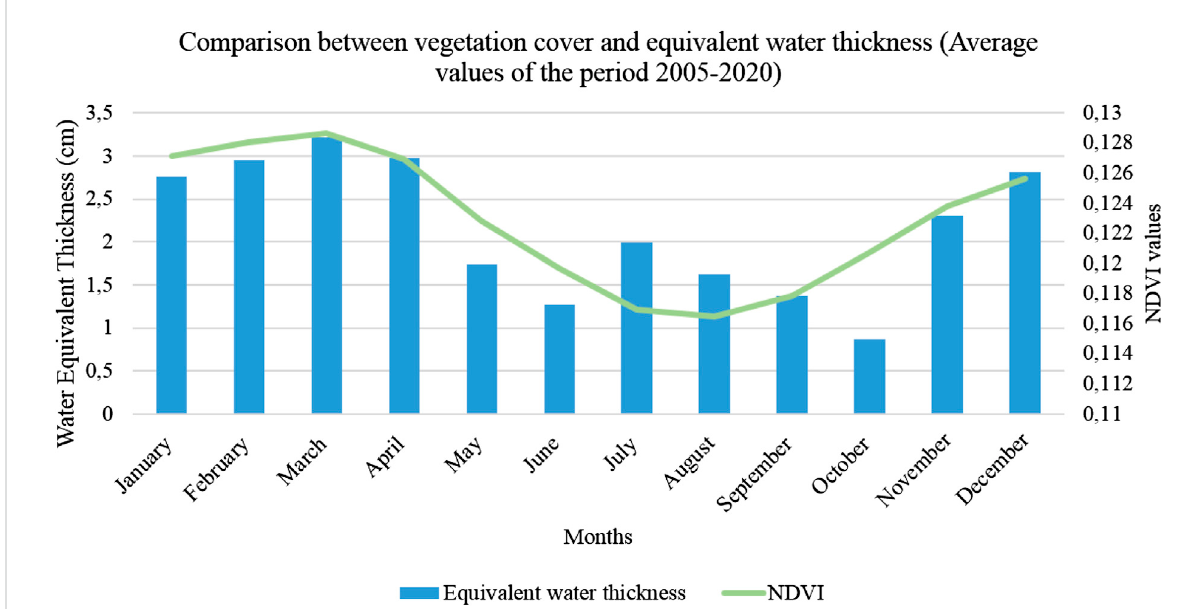
FIGURE 6 Change in the vegetation cover and the equivalent water thickness of Errachidia province in the period between 2005 and 2020 using remote sensing